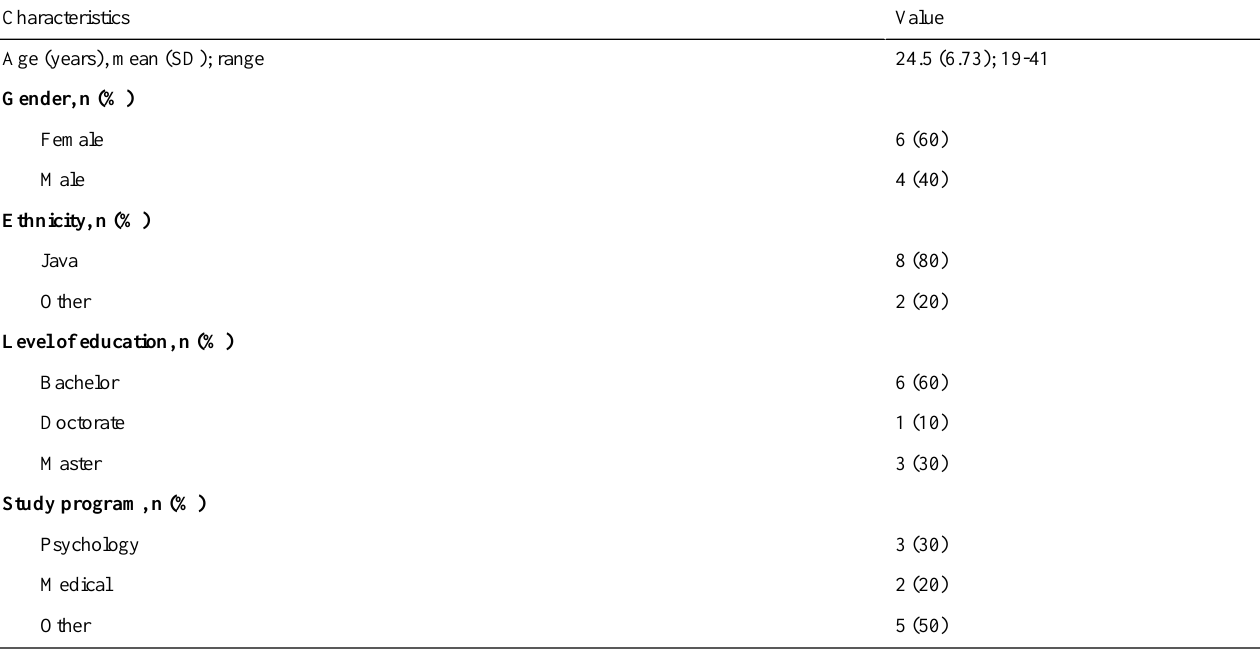
Table 1. Demographic characteristic of participants included in the semistructured interview